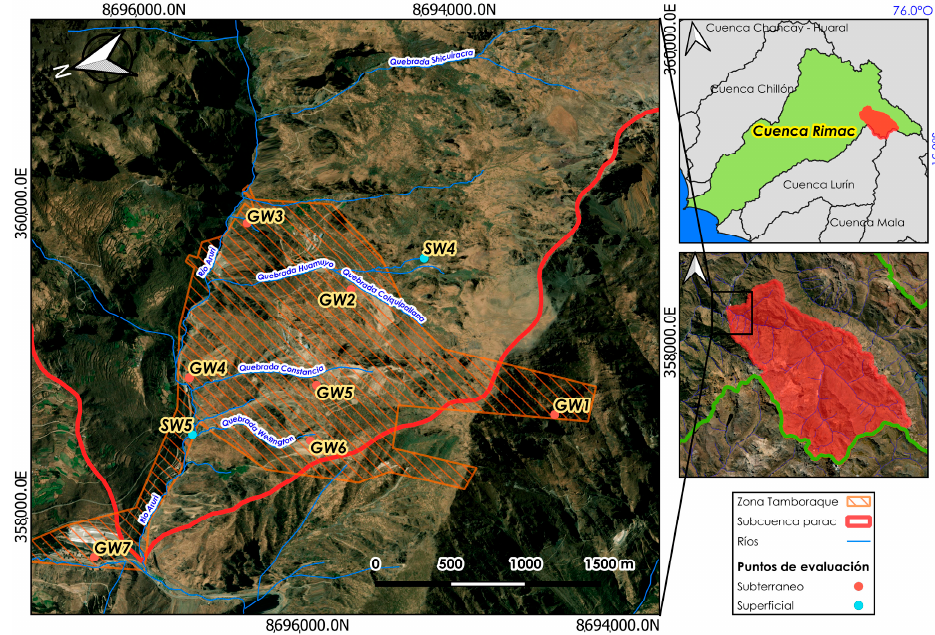
Figure 1. Study area and sampling locations.